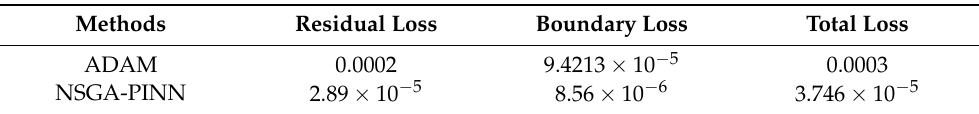
Figure 7. Burgers equation: group of figures from left to right columns show each loss value by using different training method. Table 3. Burgers equation: Comparison of the loss value from NN trained by ADAM method and NSGA-PINN method for Burgers